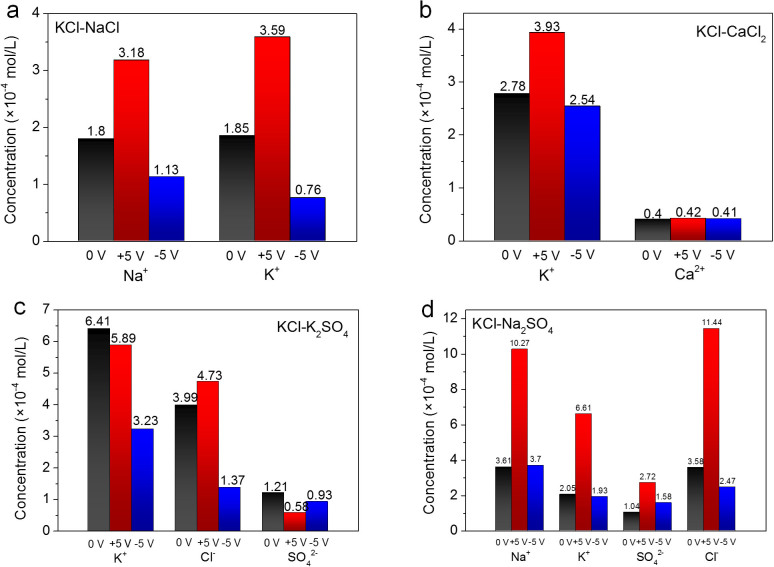
Ion concentrations of the drains during the penetrations of (a) KCl-NaCl, (b) KCl-CaCl2, (c) KCl-K2SO4 and (d) KCl-Na2SO4 hybrid sources when applying electric fields with opposite directions.